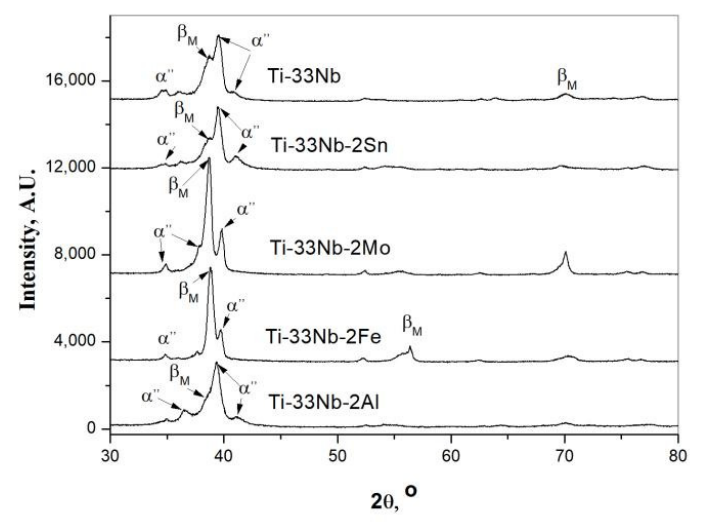
Figure 2. X-ray diffraction profiles of the water-quenched Ti-33Nb-2X (X = Al, Fe, Mo and Sn) al- loys.